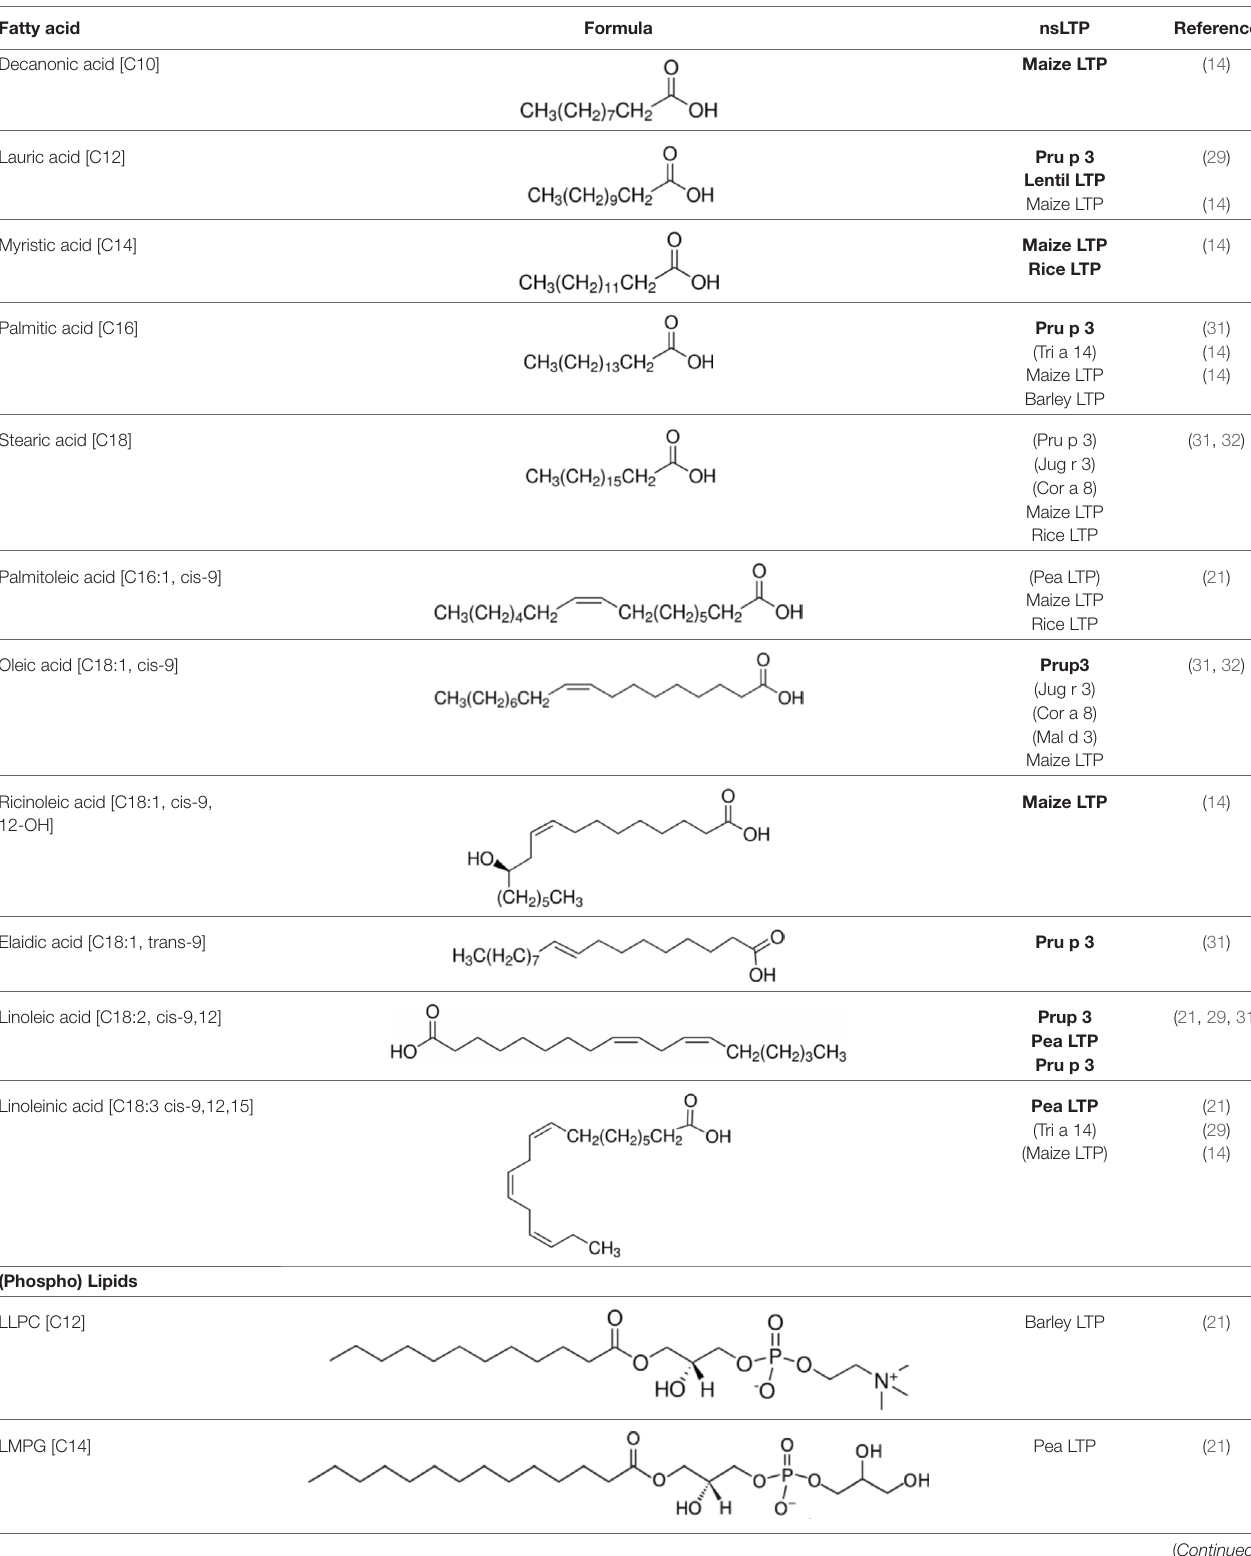
TABLe 1 | Lipophilic ligands of food-derived